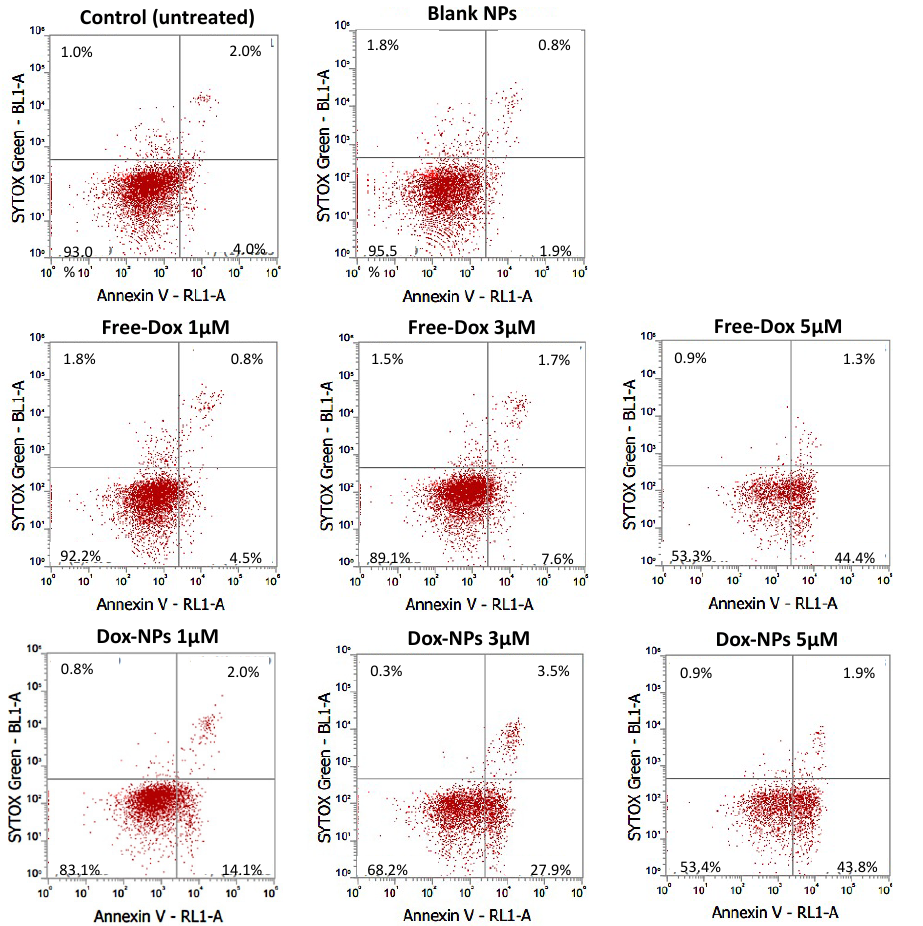
Figure 7. Apoptosis assay of HT-29 cells after treating with control (untreated), blank NPs, free Dox (1, 3, and 5 µM), and Dox-NPs (1, 3, and 5 µM). The experiments were performed using double staining technique of annexin Alexa Fluor TM 647 conjugate and SYTOX TM Green. The analysis was